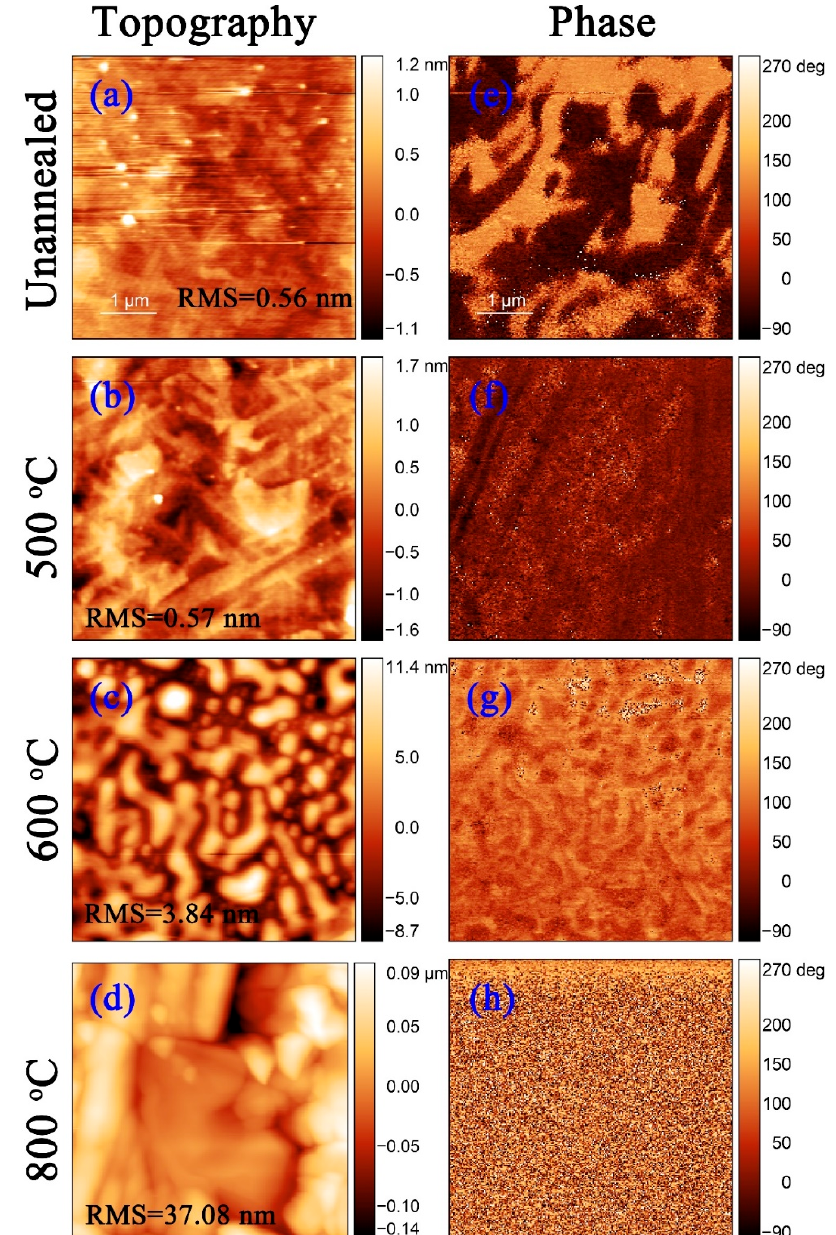
Figure 6. The PFM images of the thin polished Mn:PIMNT pyroelectric chips annealed at different temperatures: ( a–d ) topography (RMS value marked refers to the surface roughness root mean square (RMS)); ( g–h ) phase. Abbreviations: PFM, piezoresponse force microscope.